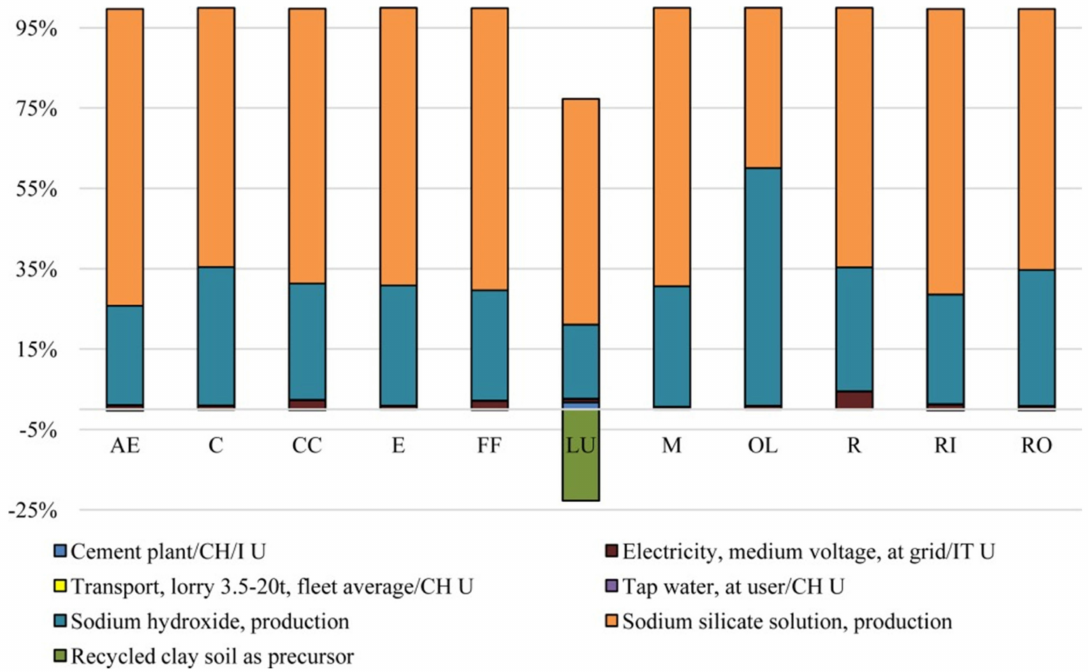
Figure 18. ECO 99 characterization values of 1212 kg of geopolymeric binder (AE: acidification / eutrophication; C: carcinogenics; CC: climatic change; E: ecotoxicity; FF: fossil fuels; LU: land use; M: minerals; OL: ozone layer; R: radiation; RI: respiratory inorganics; RO: respiratory organics). Reprinted from [85], © 2020 with permission from